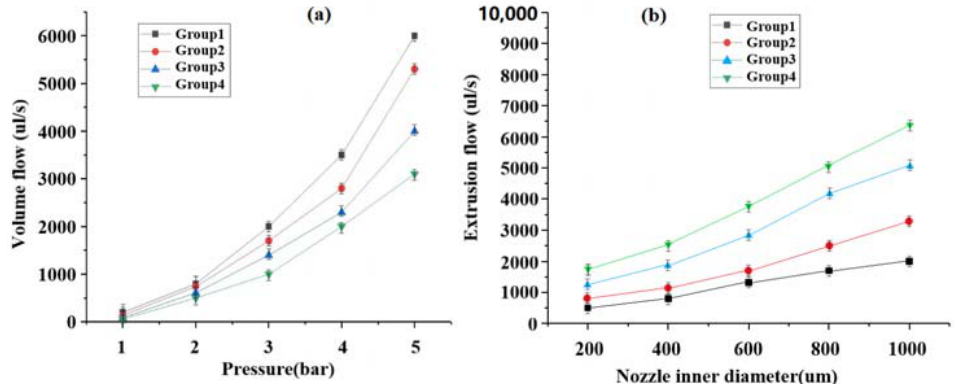
Figure 5. The extrusion flow rate correlated with the air pressure and the inner diameter of the nozzle: ( a ) Extrusion flow rates at different pressures; ( b ) Extrusion flow rates for the different inner diameters.